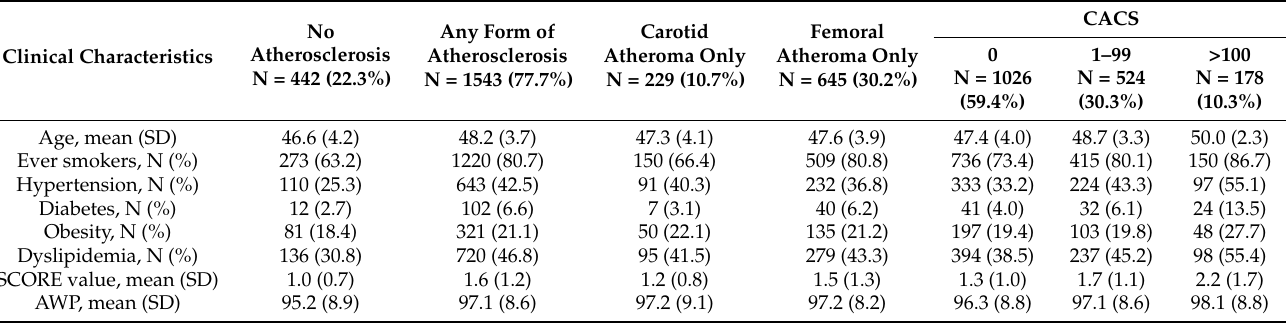
Table 2. Clinical characteristics of the study population.